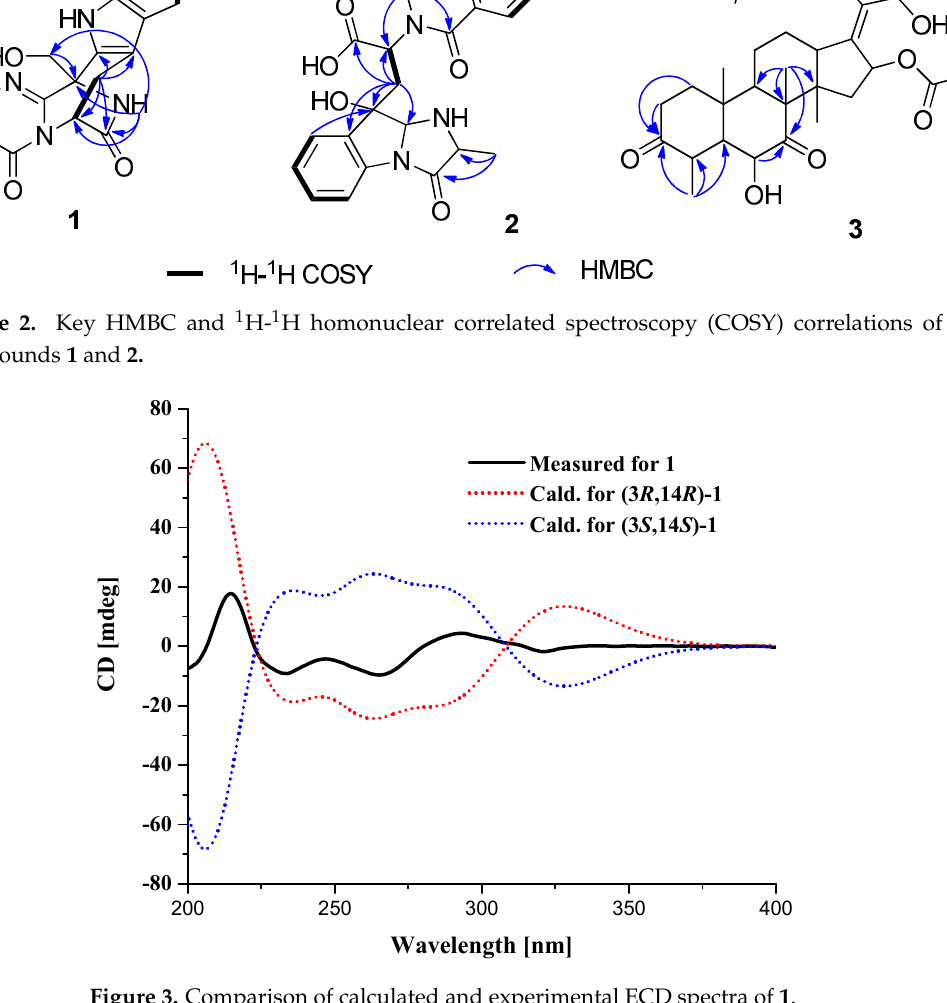
Figure 3. Comparison of calculated and experimental ECD spectra of 1 .